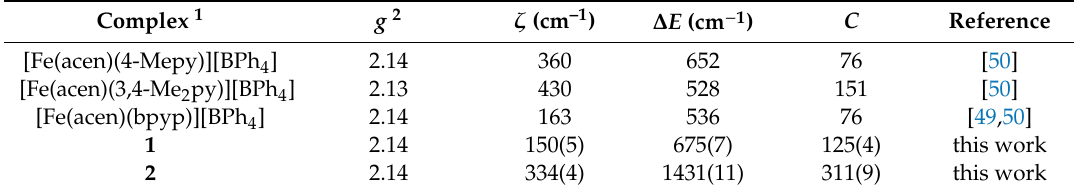
Table 3. Diagnostic spin crossover (SCO) parameters for 1 and related